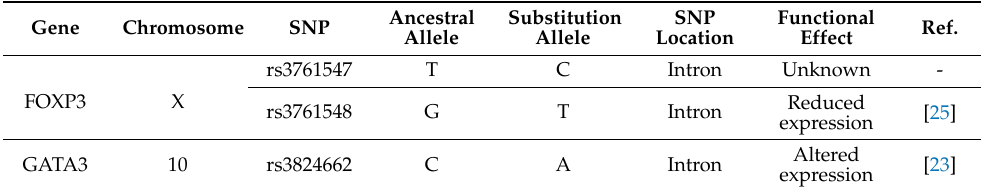
Table 1. Characteristics of FOXP3 and GATA3 single nucleotide polymorphisms (SNPs). Gene Chromosome